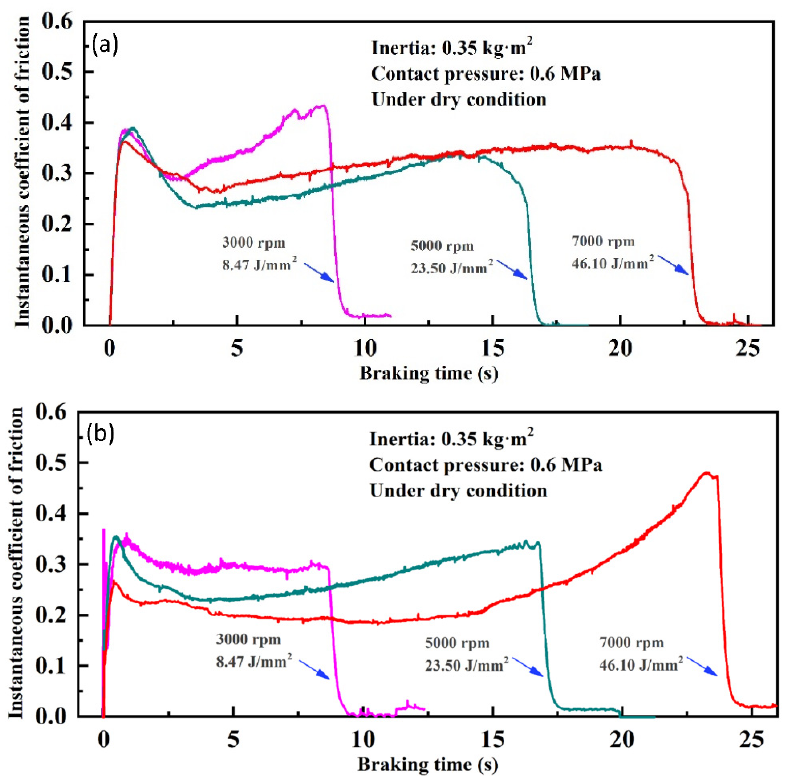
Figure 15. The instantaneous coefficients of friction of Cu–BCs containing Fe ( a ) and Cr ( b ).